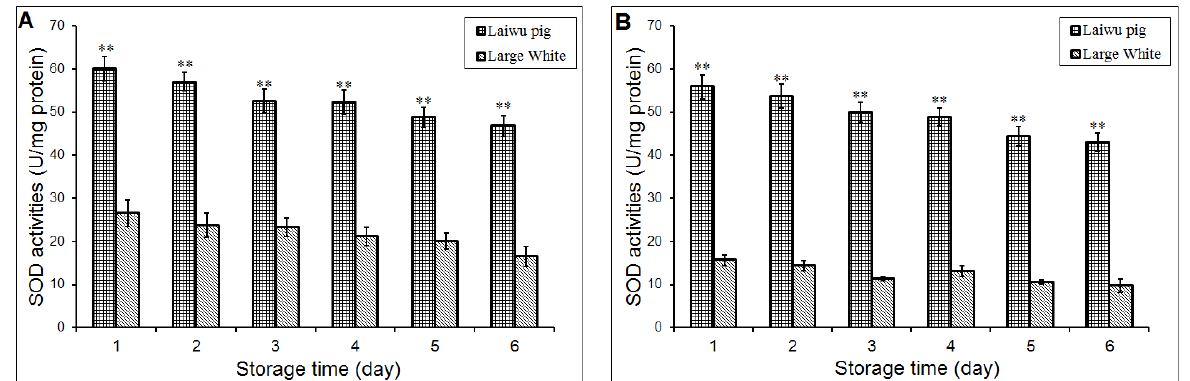
Figure 1. Comparison of muscle SOD activity. The muscle samples of Laiwu pig and Large White pig stored at 4  C (A) and 20  C (B) for 1-6 days. Each value is represented as the means  SEM ( n = 6). Asterisks indicate differences that are statistically significant (**